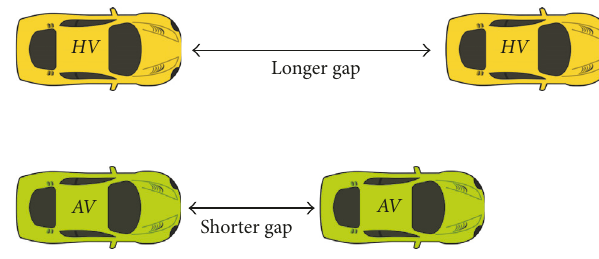
Figure 1: Shorter gaps between